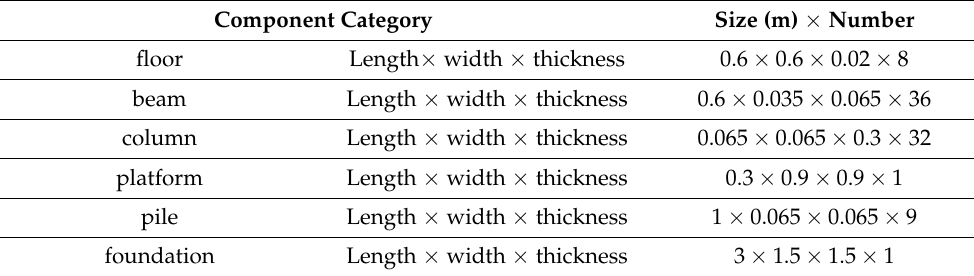
Table 1. Model Size and Number of Components.